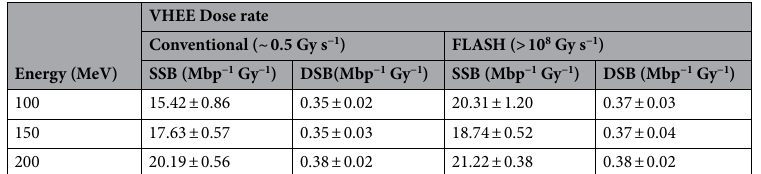
Table 2. SSB and DSB yields following dry plasmid irradiation with 100–200 MeV electrons calculated using the McMahon DNA damage fit 32 . Standard error based on three AGE repeats.